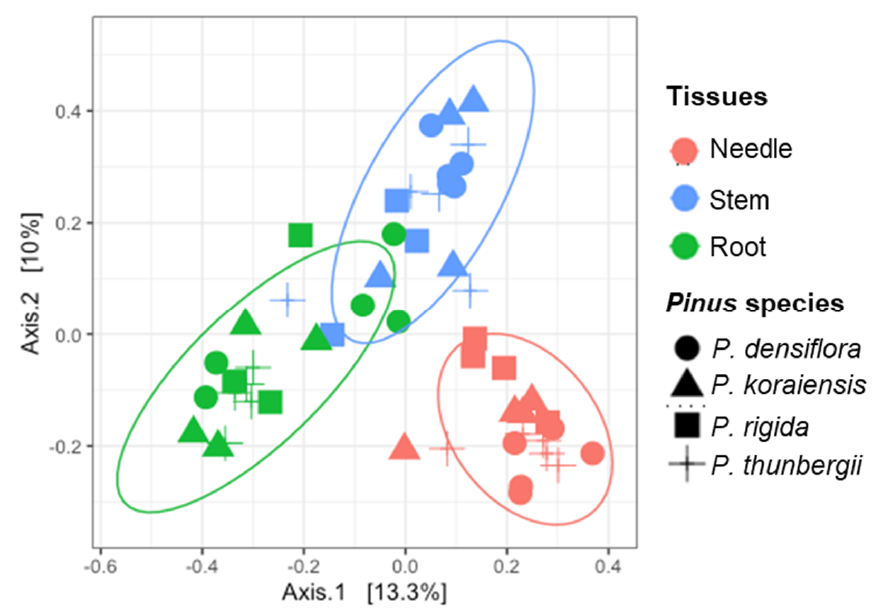
Figure 4. Principal coordinates analysis (PCoA) on Bray-Curtis distance showing the distribution of the fungal endophytes in the three different tissues (needle, stem, and root) of the four different Pinus species. Each color (pink, green, and blue) represents tissues (needle, stem, and root, respectively). Each shape (circle, triangle, square, and cross) means Pinus species ( P. densiflora , P. koraiensis , P. rigida , and P. thunbergii , respectively).